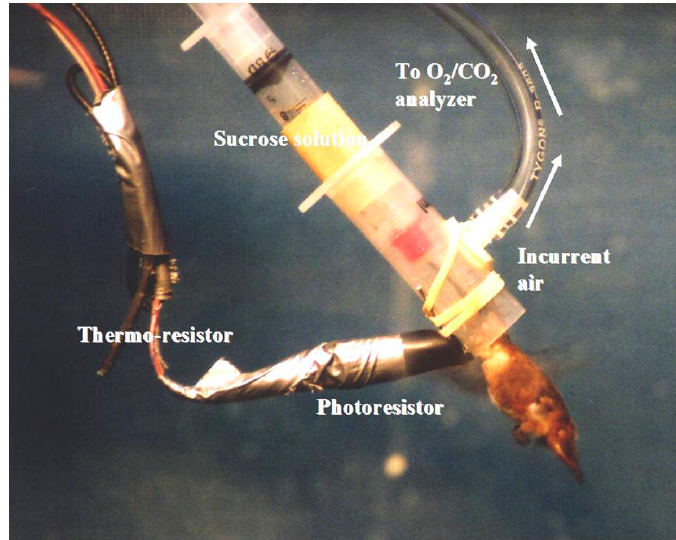
Figure 2. Hummingbird mask respirometry. The bird is freely hovering while feeding on a sucrose solution with its head in feeder modified to function as a mask for flow-through respirometry. Air is drawn into the mask at a known flow rate. The air, depleted of O 2 and enriched with CO 2 , is analyzed downstream using O 2 and CO 2 analyzers. See [20,26] for detailed description of the